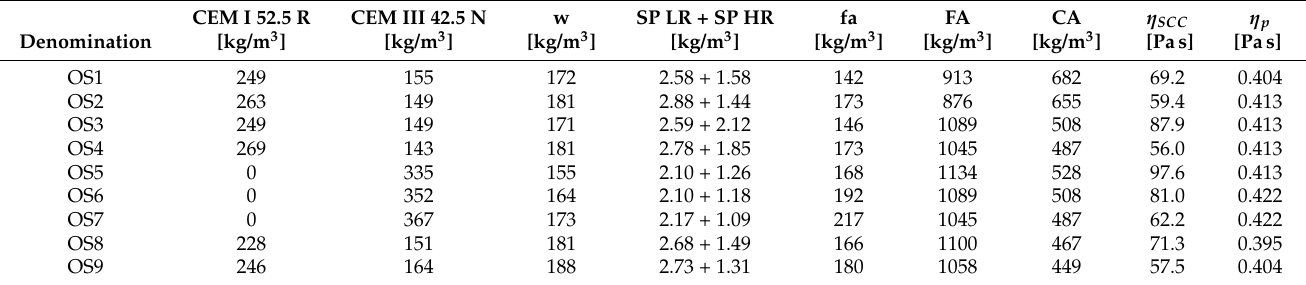
Table 1. Composition of base SCC [32] (w: Water; SP LR and HR: Superplasticizers; fa: Fly ash; FA: Fine aggregate, CA: Coarse aggregate).